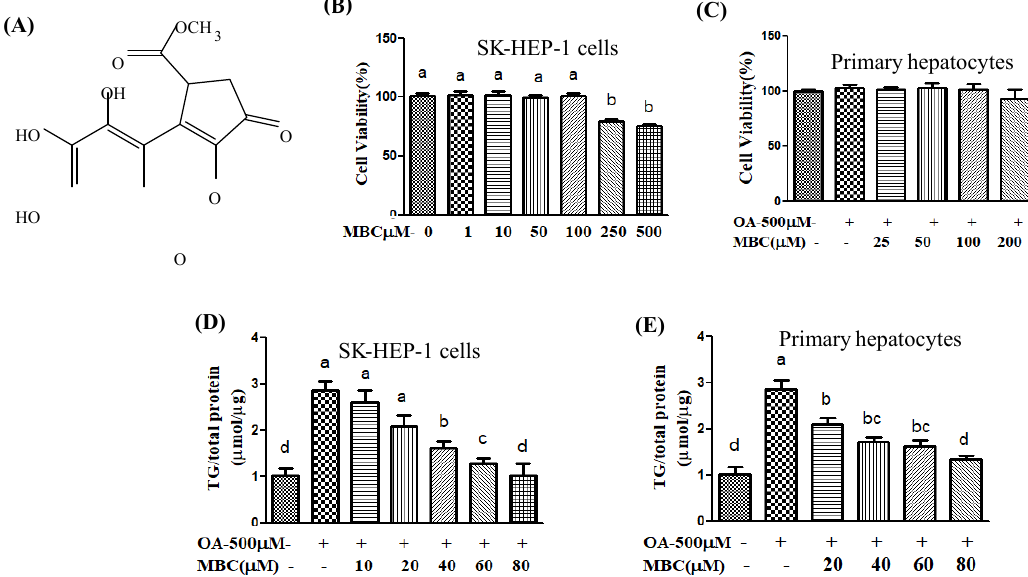
Figure 1. ( A ) Chemical structure of methyl brevifolincarboxylate (MBC). ( B , C ) Effect of MBC on viability of SK-HEP-1 cells and murine primary hepatocytes, respectively, as determined by Alamar Blue assay. The absorbance was measured at 570 and 600 nm. The cell survival rate (CSR) was calculated on basis of OD. ( D , E ) Effect of MBC on triglyceride (TG) levels in OA-treated SK-HEP-1 cells and primary murine hepatocytes, respectively. Total TG was analyzed using Randox Triglyceride Assay kit. Results were presented as the mean ± SD of three independent experiments. Data bars with similar let ers were not significantly different ( p ≤ 0.05).